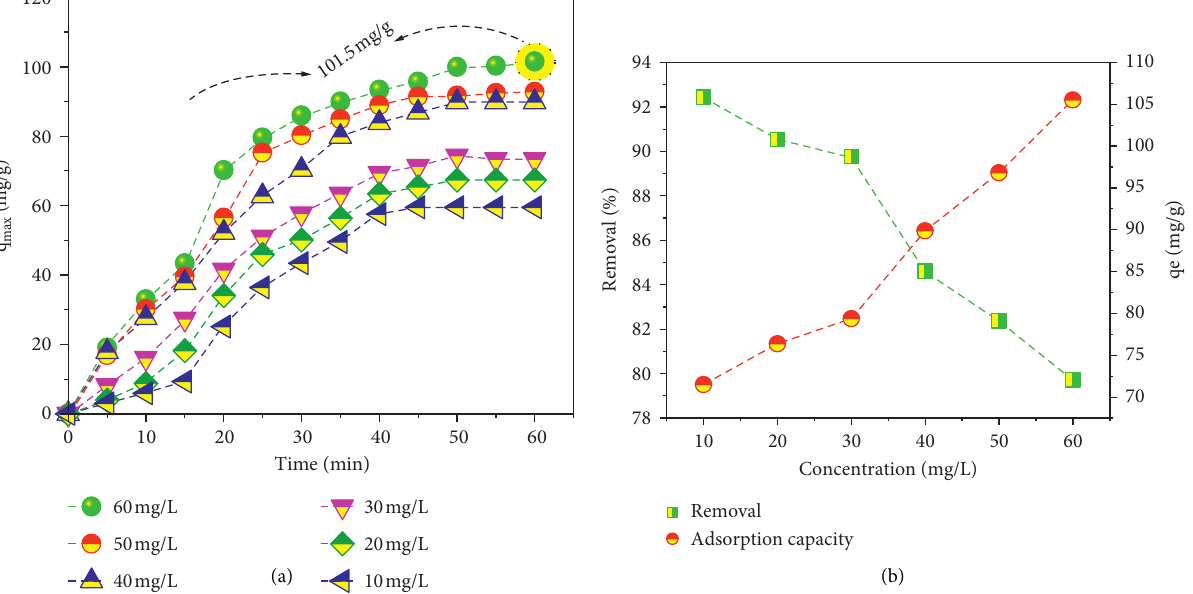
Figure 7: Initial RBB concentration effect on the adsorption process (a) and the optimal RBB concentration during the adsorption phenomenon (b).